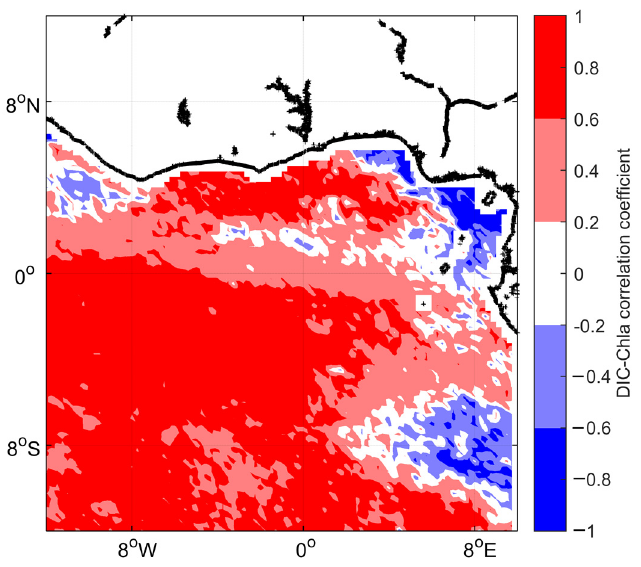
Figure 10. Map of correlations between chlorophyll and DIC concentrations calculated over 12 climatological months.